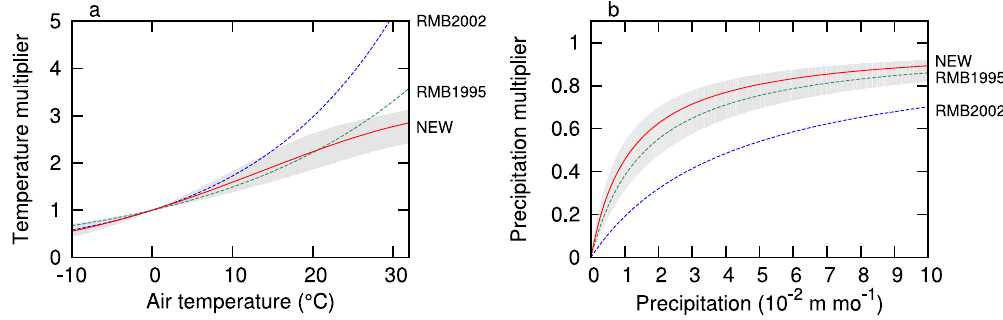
Figure 1. Shapes of the temperature function (a) and precipitation function (b) . The red line represents the results of this study, and the green-dashed and blue-dashed lines indicate the functions estimated by previous studies (Raich and Potter, 1995; Raich et al., 2002). The grey area is the 95% confidence interval of the estimated functions. Table 1. A priori and a posteriori probability distributions of the parameters. The MAP is the maximum a posteriori estimate. A uniform distribution was assumed for every a priori distribution. CI indicates the confidence interval. F , a , b , K , and α are the model parameters, and σ is the standard deviation of the model–data error. Parameters Prior MAP Mean Median SD 95% CI Kurtosis Geweke’s P Geweke’s